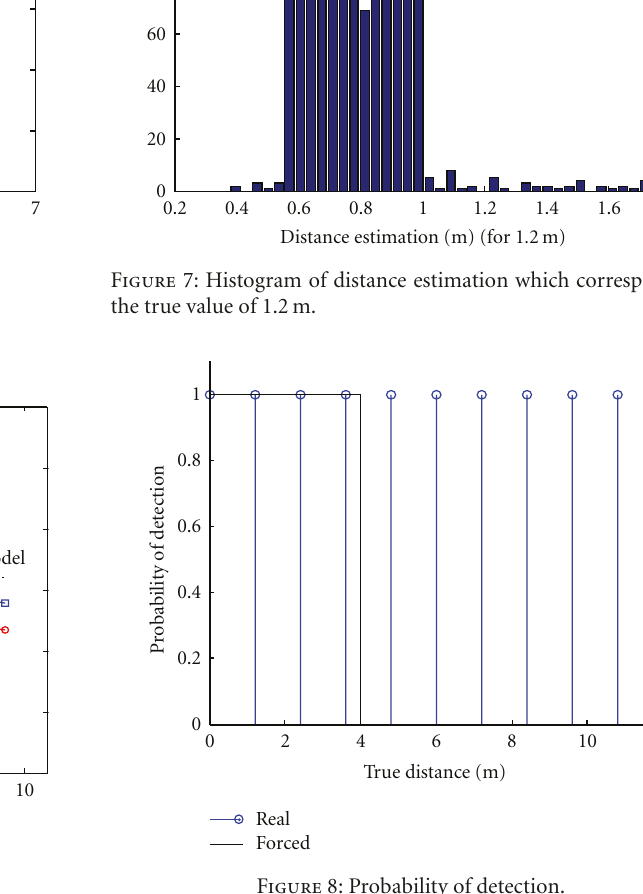
Figure 8: Probability of